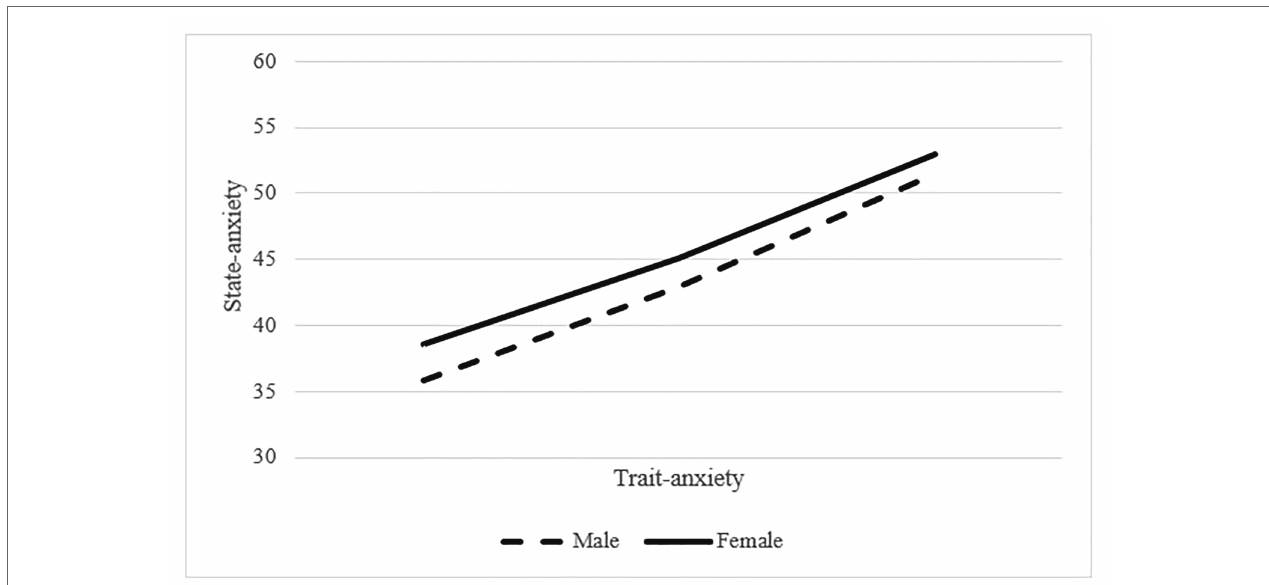
FIGURE 1 | The associations between trait-anxiety and